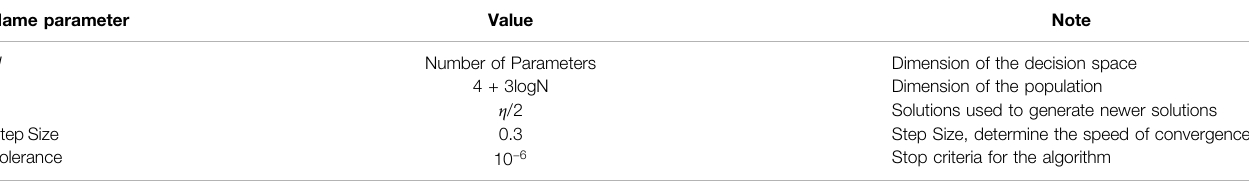
TABLE 3 | CMA-ES parameters.